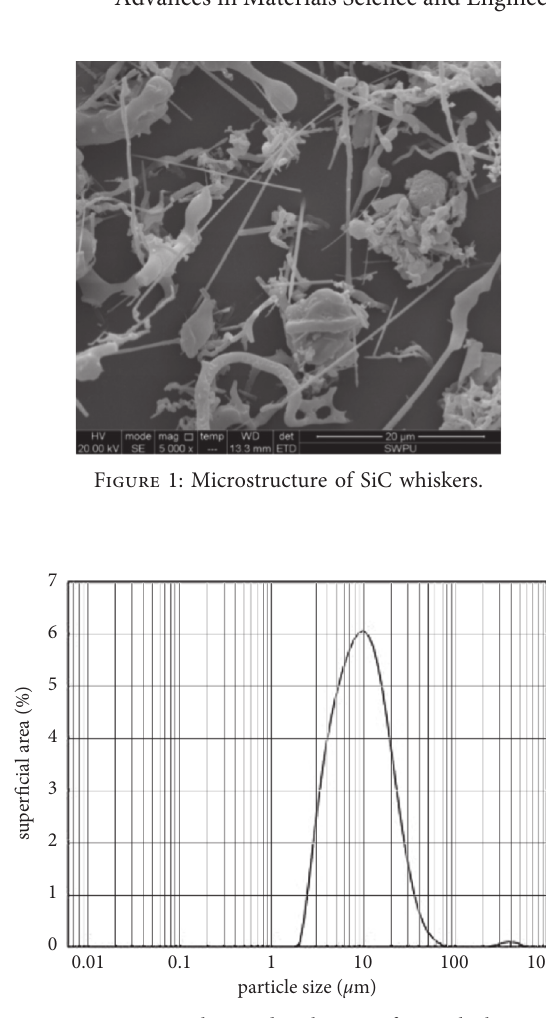
Figure 2: Particle size distribution of SiC whiskers. Table 1: The chemical composition of